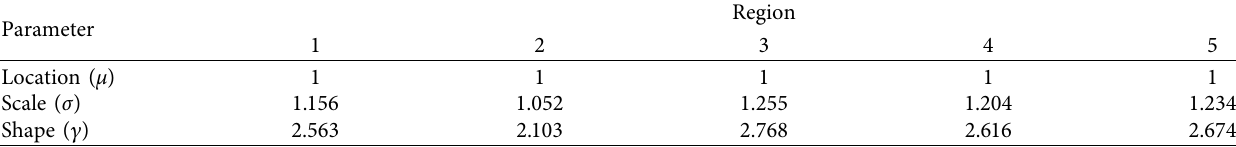
Table 5: Estimated regional distribution parameters of PE3 for the five homogeneous regions.